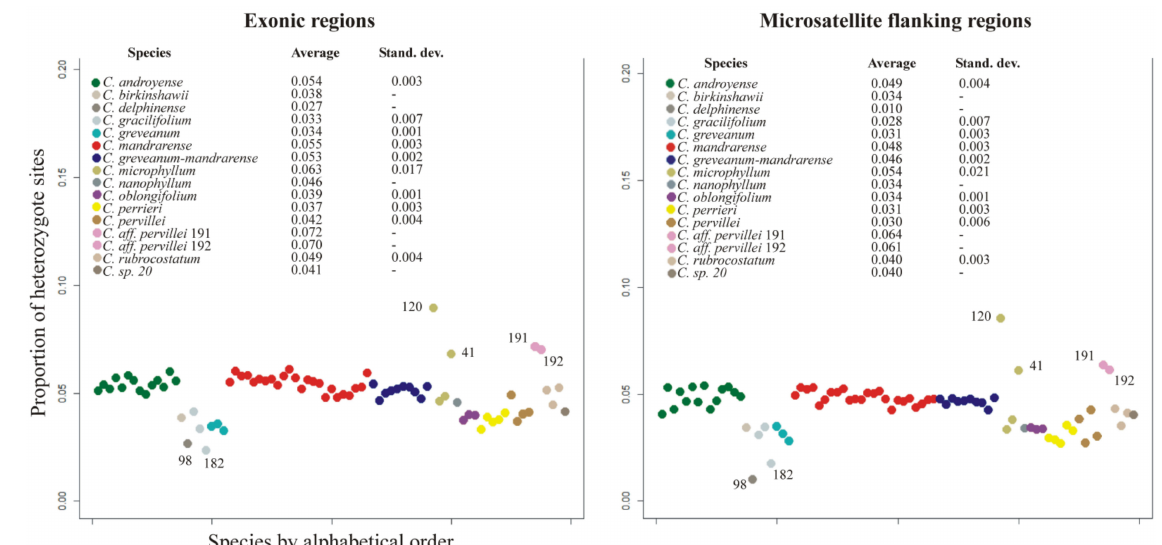
Figure 2. Proportion of heterozygous sites for exons (average 0.051, sd 0.013) and microsatellite flanking regions (0.045, sd 0.014), with average and standard deviation of each taxa indicated.